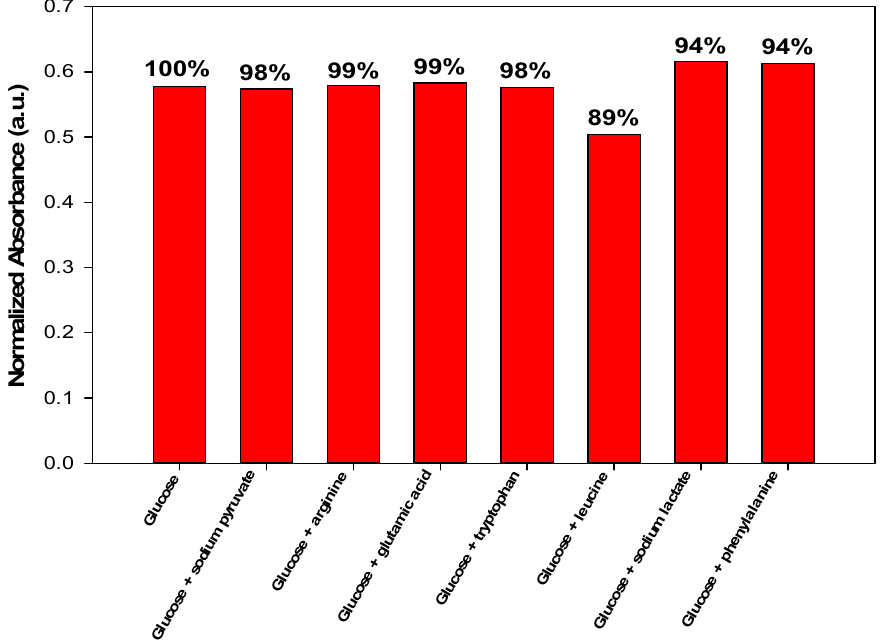
Figure 5. Effect of different interfering species on the response of optode 3 in presence of glucose.